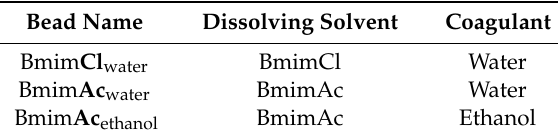
Table 1. The ionic liquids (ILs) and coagulants used for the preparation of three types of cellulose